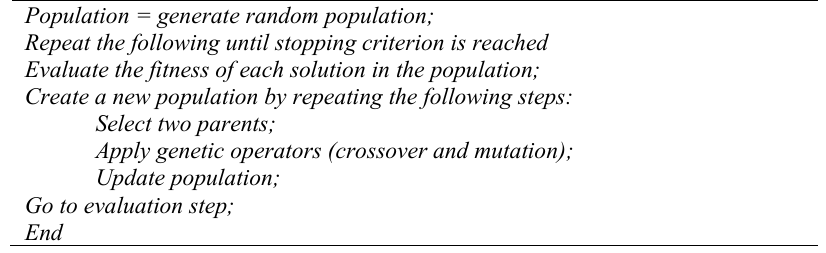
Fig. 1. Pseudocode for the traditional